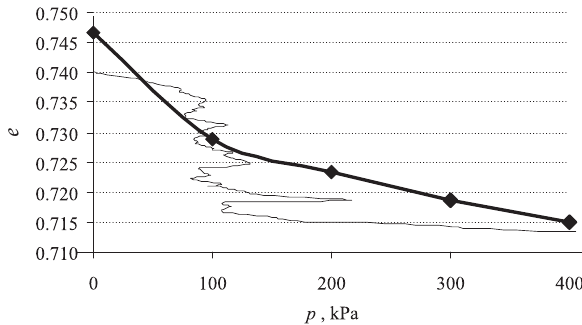
Fig. 11. Variation of the void ratio vs. pressure for Sample 1